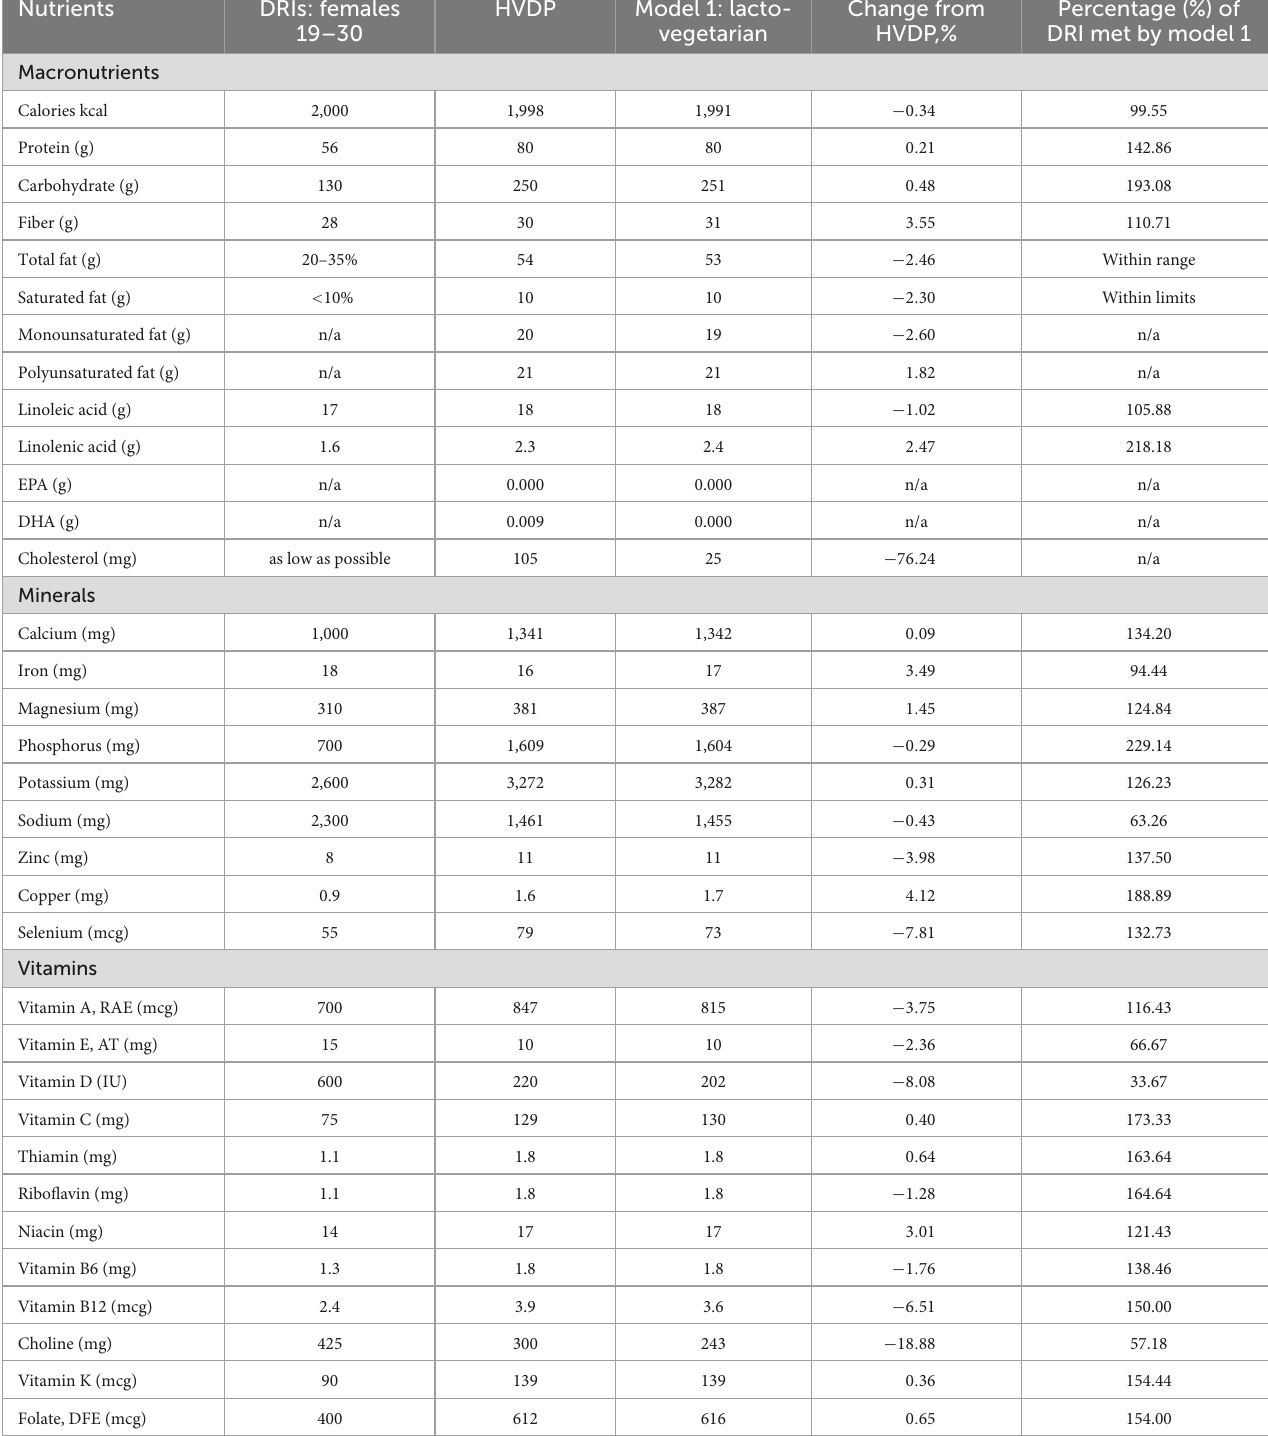
TABLE 4 Impact of replacing eggs in the 2,000 kcal/d Healthy Vegetarian Dietary Pattern (HVDP) with vegetarian protein group foods on Dietary Reference Intakes (DRIs) for females 19–30 y. Nutrients DRIs: females HVDP Model 1: lacto- Change from Percentage (%) of 19–30 vegetarian HVDP,% DRI met by model